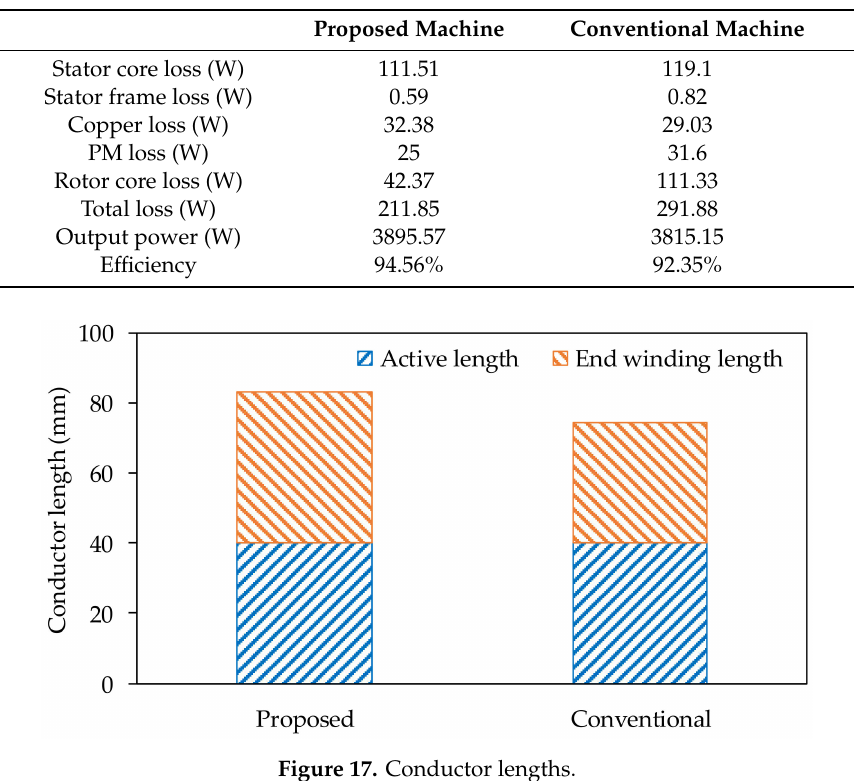
Table 5. Losses and e ffi ciencies of the two compared machines.